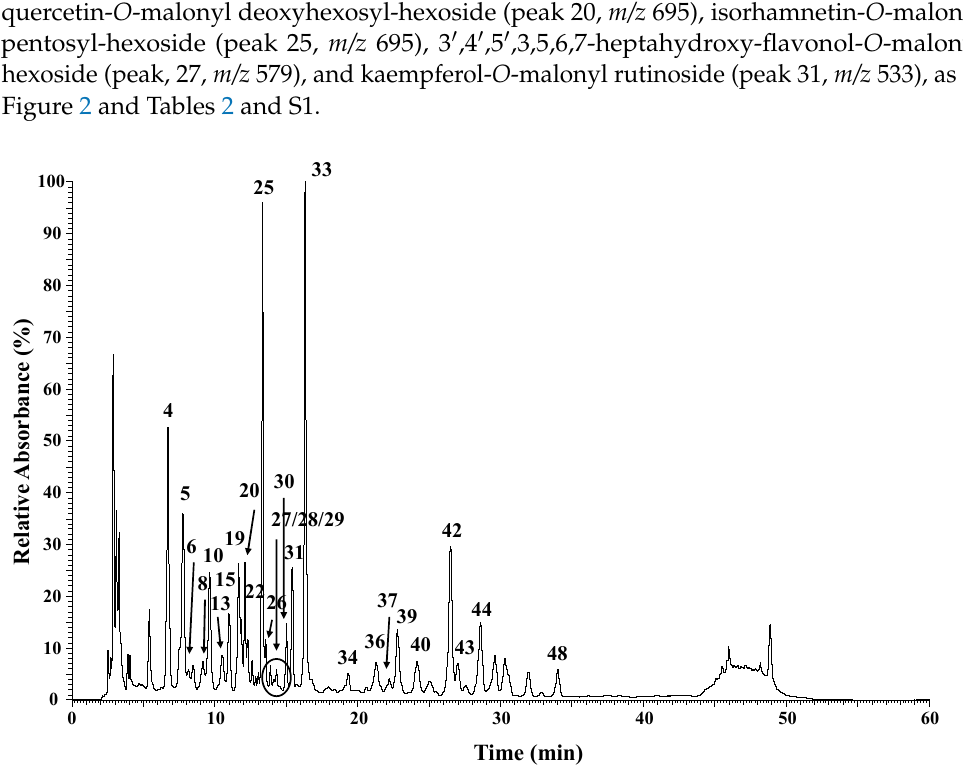
Figure 3. Mass fragmentation pattern for the tentative identification of ( a ) myricetin ‐ O ‐ acetyl deoxyhexosyl ‐ hexoside and ( b ) myricetin ‐ O ‐ malonyl hexoside present in sample BP6. Compounds such as as quercetin ‐ O ‐ diglucoside, kaempferol ‐ O ‐ diglucoside, and kaempferol ‐ 3 ‐ O ‐ rutinoside—assigned to the precursor ions [M ‐ H] ‐ at m/z 625, m/z 609, and m/z 593—were the most common flavonoid glycosides within all samples. These compounds have been reported in Portuguese bee pollen, which had predominantly Plantago sp., Crepis capillaris , and Cytisus striatus pollen species [10]. Comparing the samples individually, BP6 exhibited a profile with more diversity of phenolic compounds and the highest total concentration (8.8 mg/g), which was in accordance with the previous results in the flavonoid content of it. A similar situation was observed for the BP3 sample concerning the diversity of compounds. This could be related to the polyfloral nature of BP3 and BP6, for which different plant sources contribute to the high diversity of compounds. On the other hand, BP2, with 60% Brassica pollen, was the poorest in terms of compounds. Chromatographic results also revealed that Moroccan bee pollen samples contained four phenolic acids—caffeic acid ( m/z 179), caffeic acid hexoside ( m/z 341), p ‐ coumaric acid ( m/z 163), and p ‐ coumaric acid hexoside ( m/z 325)—at low concentrations in BP1, BP2, BP5, and BP8. Such phenolic acids have a wide distribution in